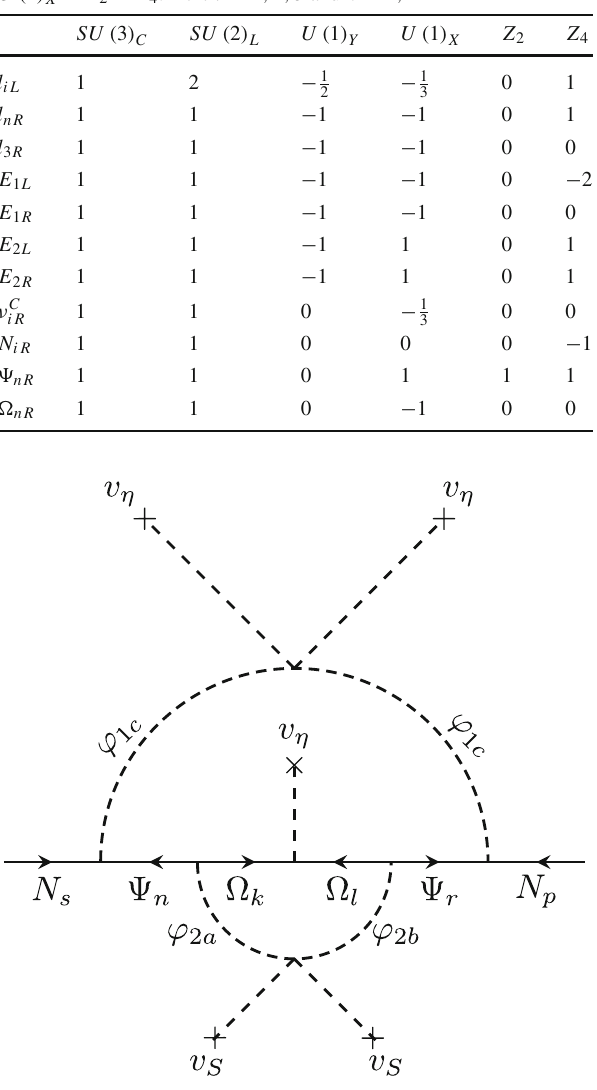
Fig. 2 Two-loop Feynman diagram contributing to the Majorana neu- trino mass submatrix μ . Here n , k , l , r = 1 , 2, s , p = 1 , 2 , 3, a , b , c = R , I , with ϕ nR and ϕ nI corresponding to the CP even and CP odd parts of the scalar field ϕ n ,